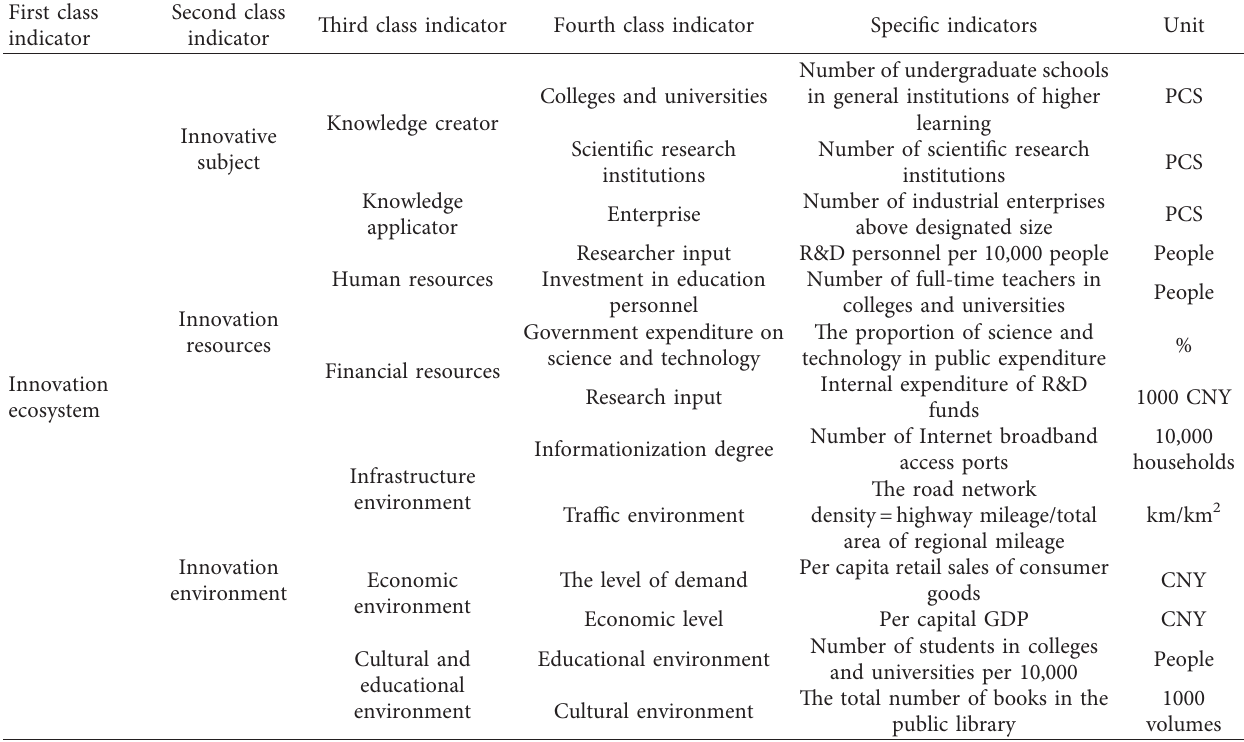
Table 1: Index construction of innovation